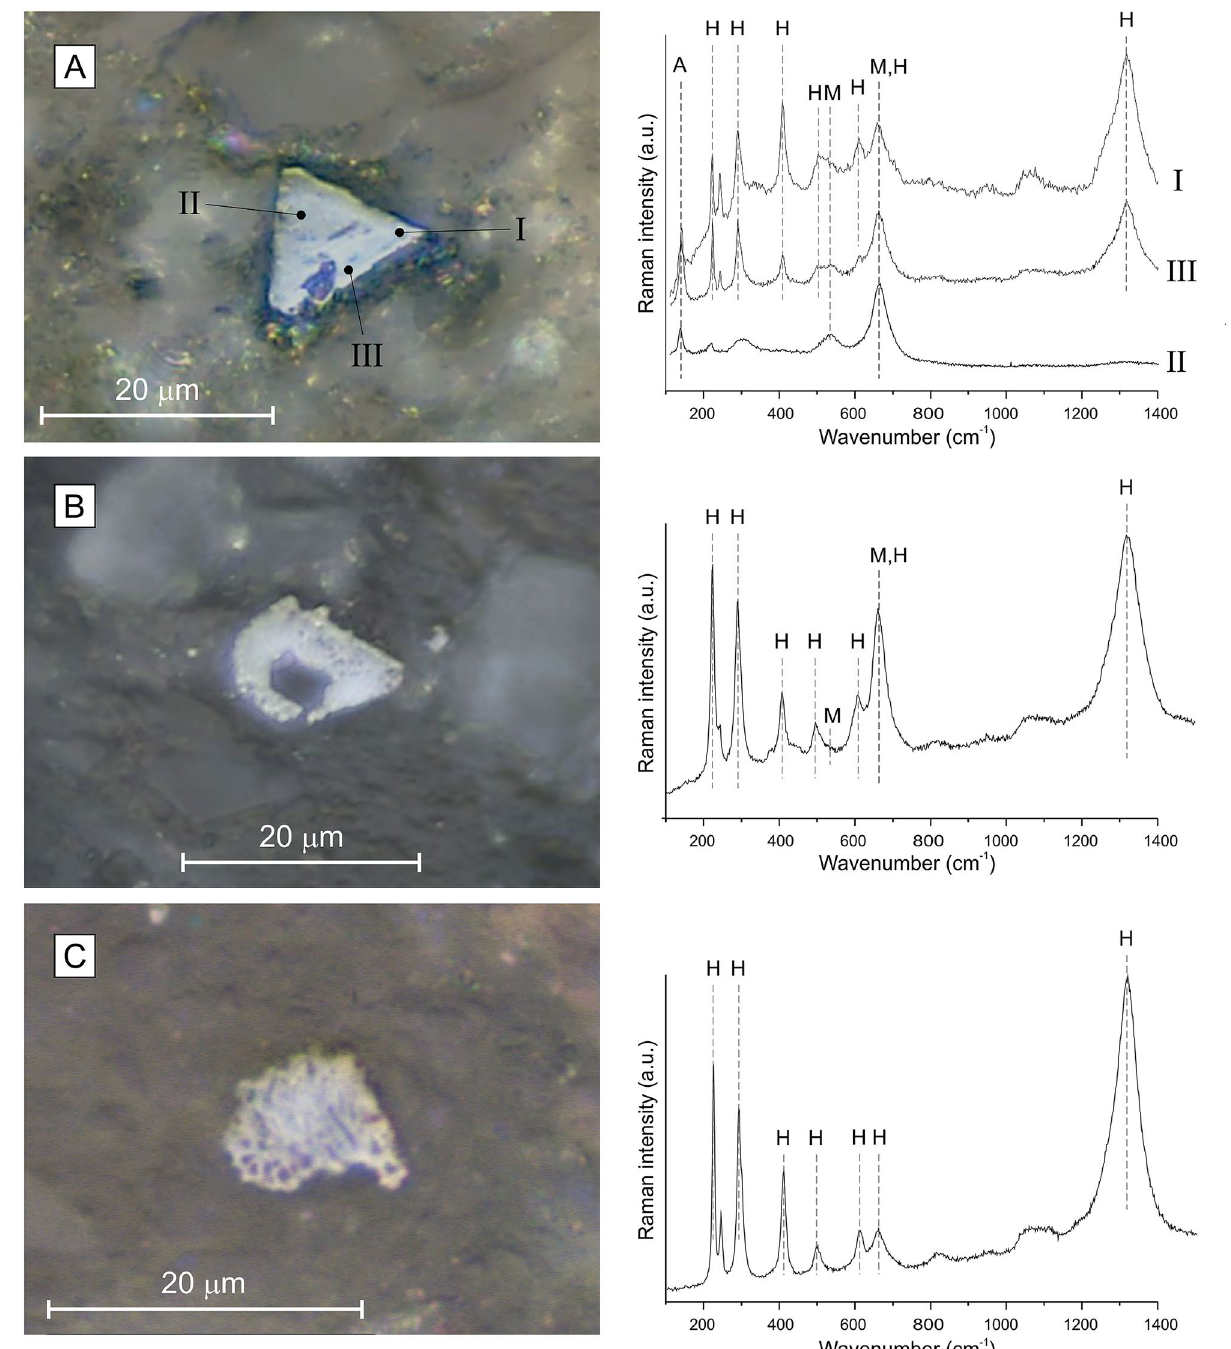
Figure 4. Typical reflected light microscopic photographs of martite and corresponding micro-Raman spectra observed in the brownish layers. Particles show the typical habit of magnetite with a mixed composition of magnetite (M) and hematite (H). I, II and II in the top right panel belong to spots I to